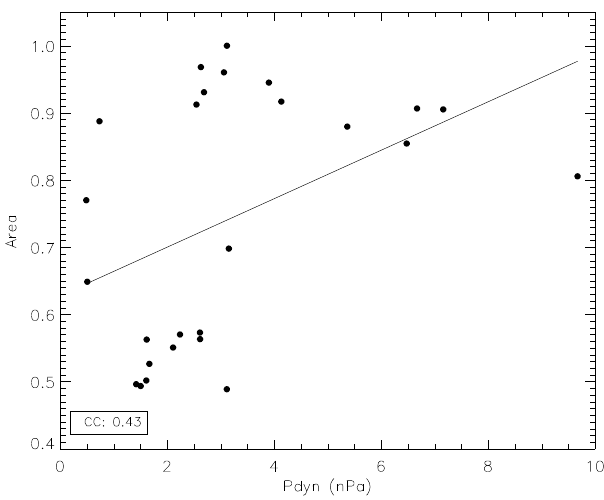
Figure 17. The relationship between the area of CRW and the solar wind dynamic pressure ( P dyn ) during different time of geomagnetic storm on 13 November 1998. The y axis has been